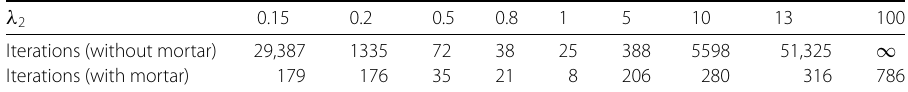
λ 2 0.15 Iterations (without mortar) Iterations (with mortar)